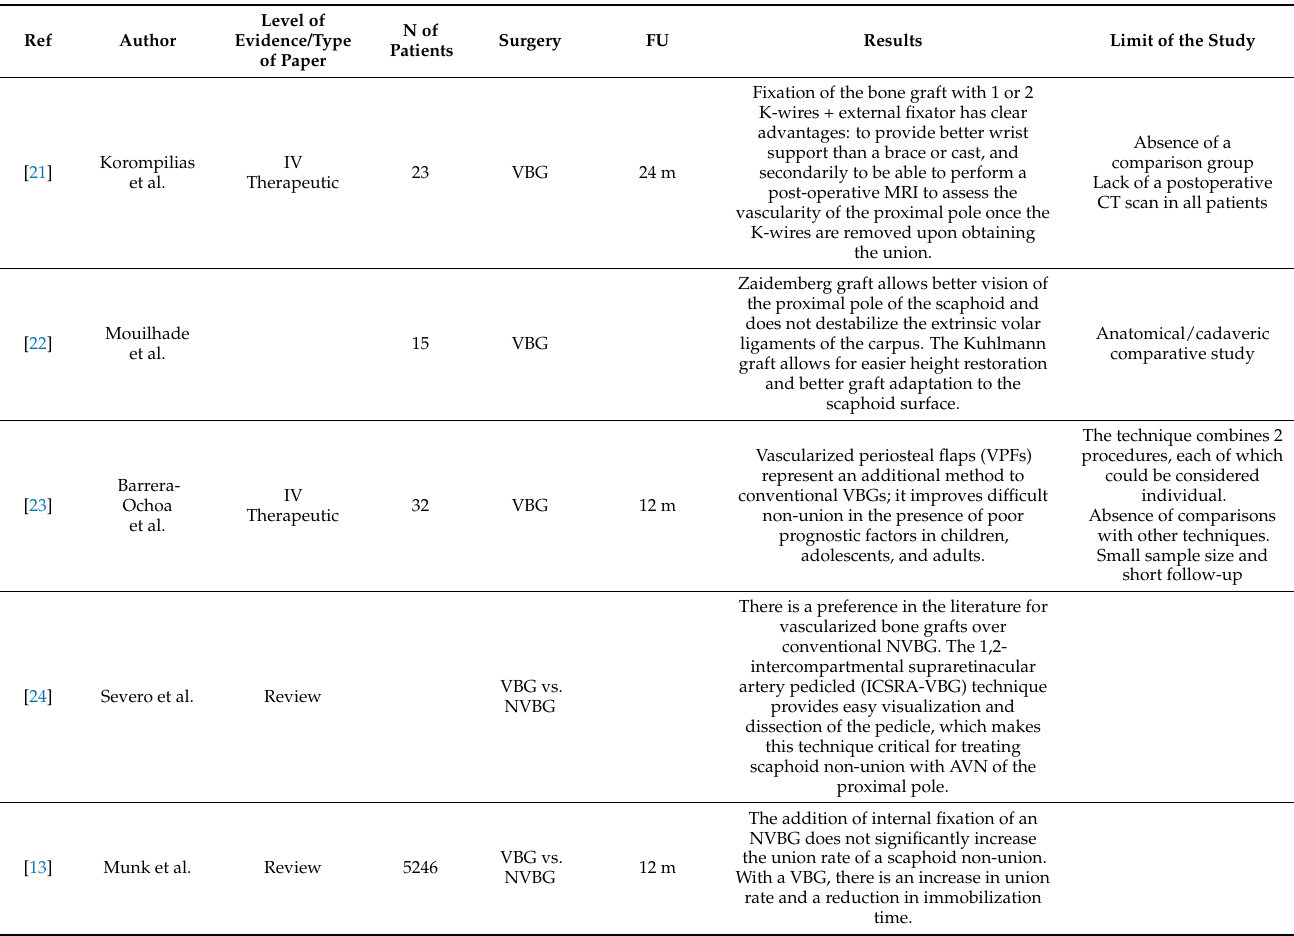
Table 1. The main results of the non-scaphoid unions included metanalysis, systematic reviews, case studies, cohort studies, and prospective and retrospective